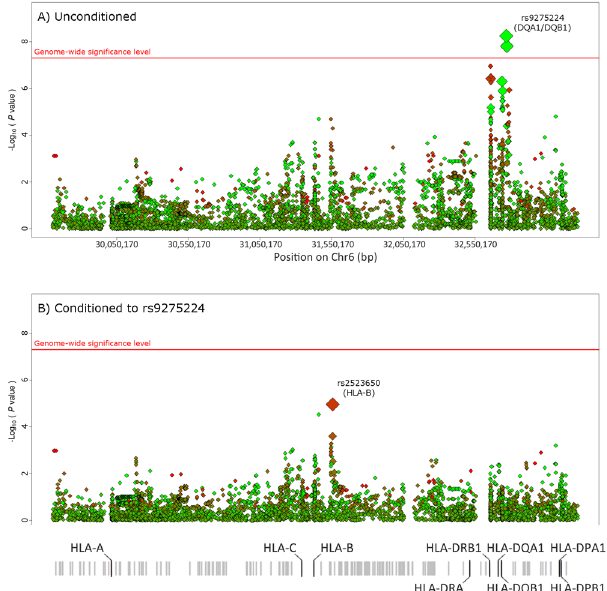
Figure 2. Manhattan plot representation of the step-wise conditional logistic regression of the HLA region. ( A ) Unconditioned test of the HLA region. ( B ) Results of the HLA region after controlling for rs9275224. The − log10 of the p values are plotted against their physical chromosomal position. A red/green color gradient was used to represent the effect size of each analyzed variant (red for risk and green for protection). The red line represents the genome-wide level of significance (P <